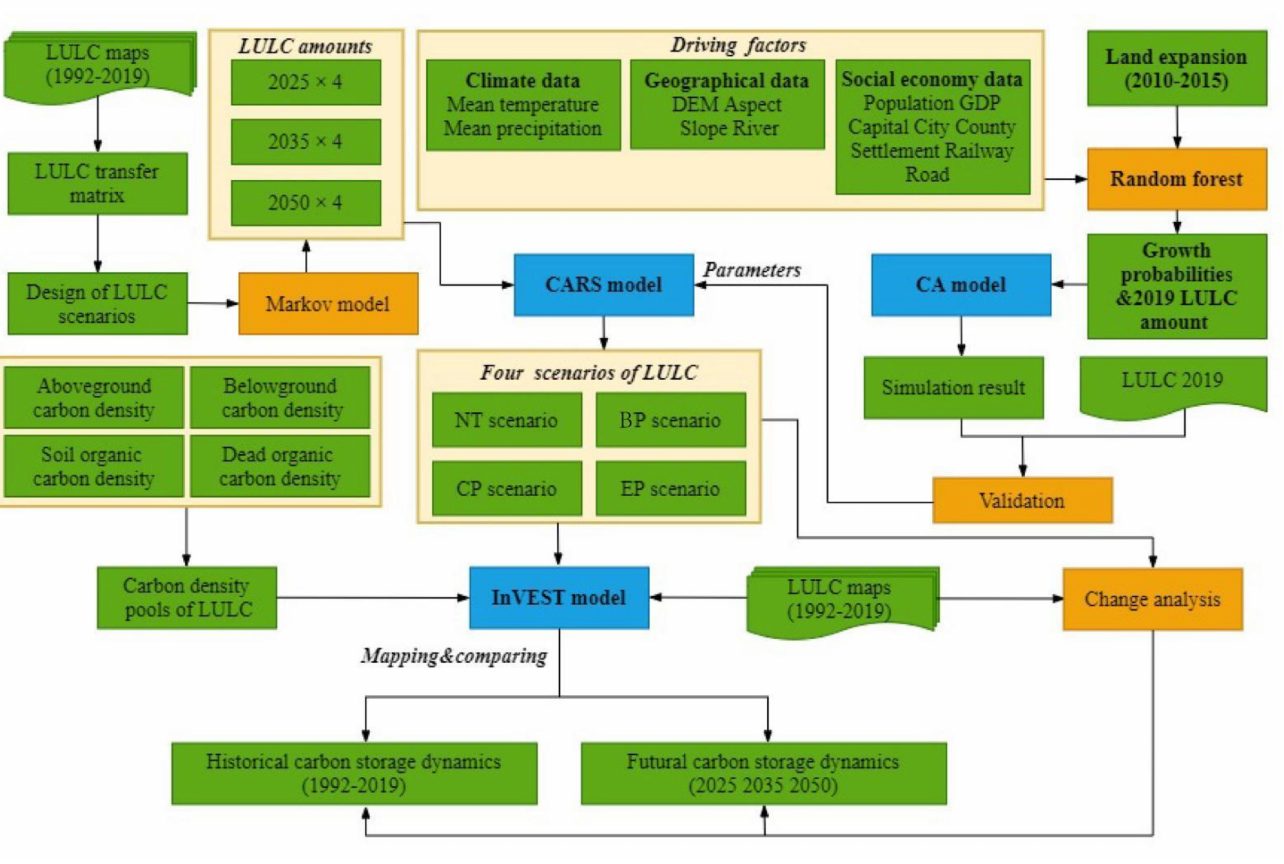
Figure 3. The research flow chart of this